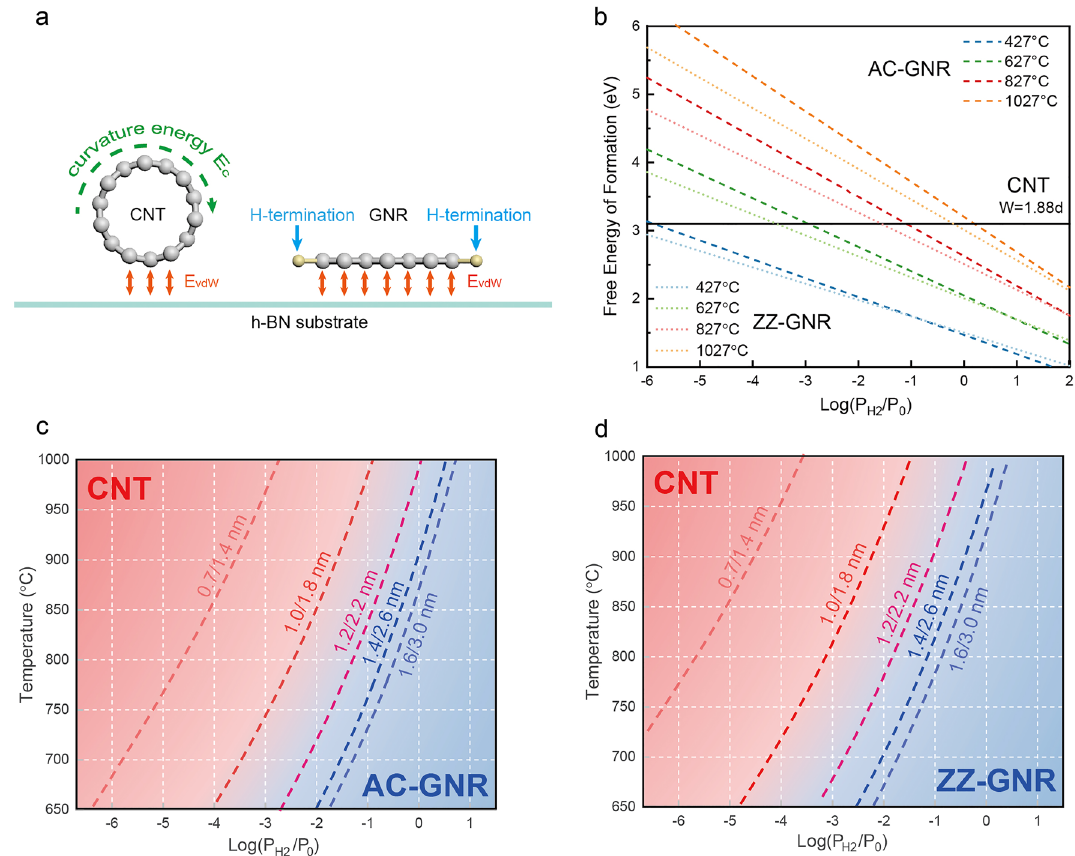
Figure 3. Competing nucleation between GNRs and CNTs. ( a ) Schematic of a tubular CNT and a planer GNR on h-BN substrate. ( b ) Free energy of formation of CNTs (black line) and zigzag/armchair (dot lines/dash lines) GNRs as a function of H 2 pressures at a few representative temperatures. ( c , d ) Theoretical growth phase diagram. Red and blue regions stand for energetically favorable for growing CNTs and GNRs, respectively. The dashed lines represent equal probability of yielding GNRs and CNTs of different width and diameter. The diameter and the width of the compared CNTs and GNRs are denoted along the dash lines (CNTs’ diameter/ GNRs’